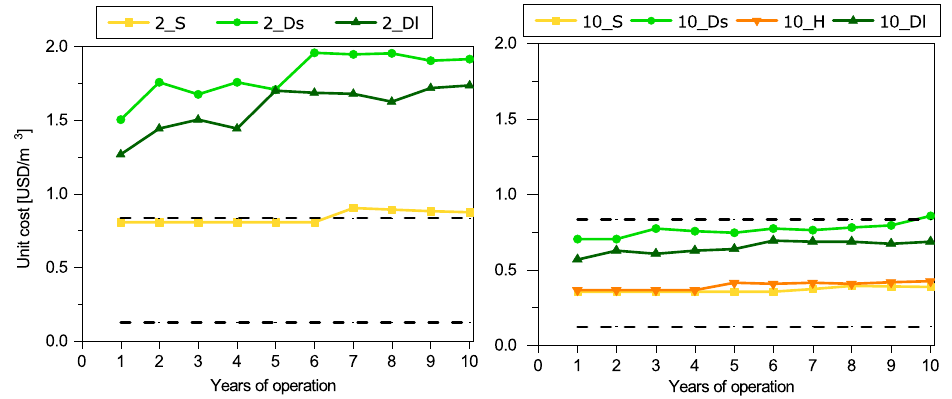
Figure 6. Overview of OPEX (USD/m 3 ) for the 2 m 3 /h (left) and 10 m 3 /h (right) alternatives. The dotted lines indicate two local water fees found in the West Nile region. The OPEX increases over time because of reinvestments. Details in Supplementary Material A.18. Discount rate =